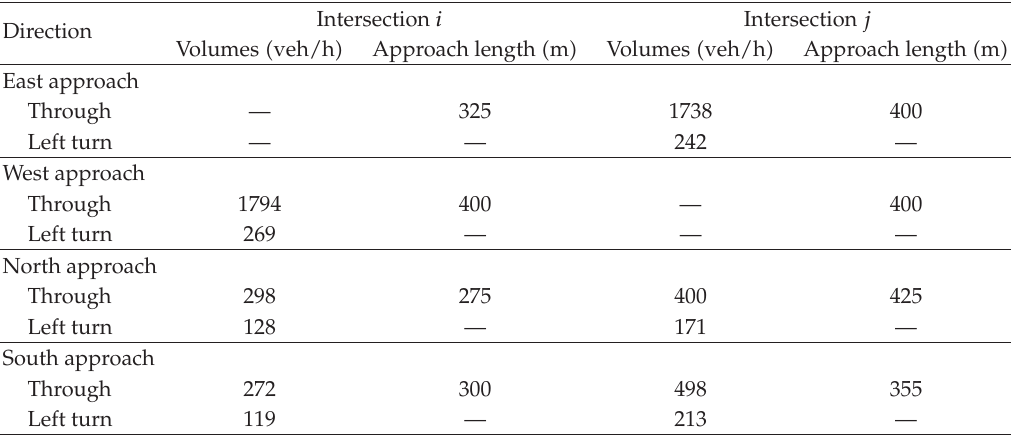
Table 1: All entry flows and approach length of the